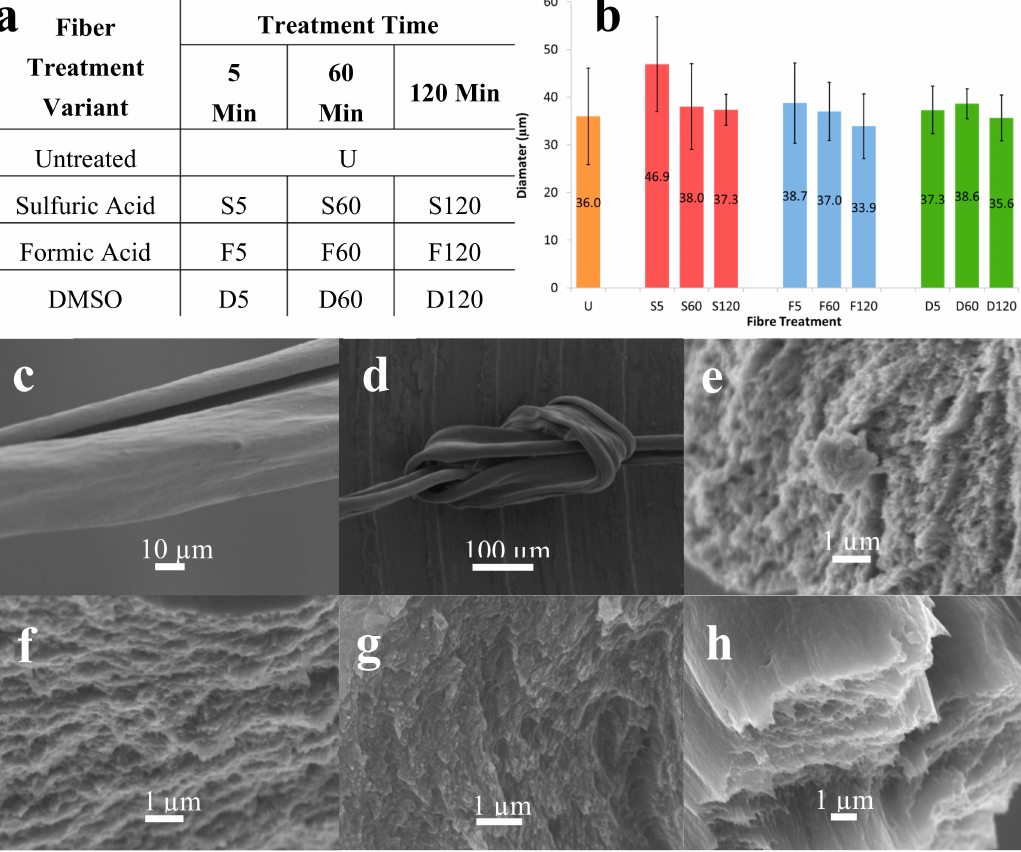
Figure 1. ( a ) Acronyms for Orgacon wet spun and chemically treated Orgacon PEDOT:PSS fibers, ( b ) average diameters of Orgacon fibers (n = 10), SEM images of: ( c ) fiber length of U, ( d ) dry knotted fiber U, ( e ) cross-section of U, ( f ) cross-section of S120, ( g ) cross-section of F120, ( h ) cross-section of